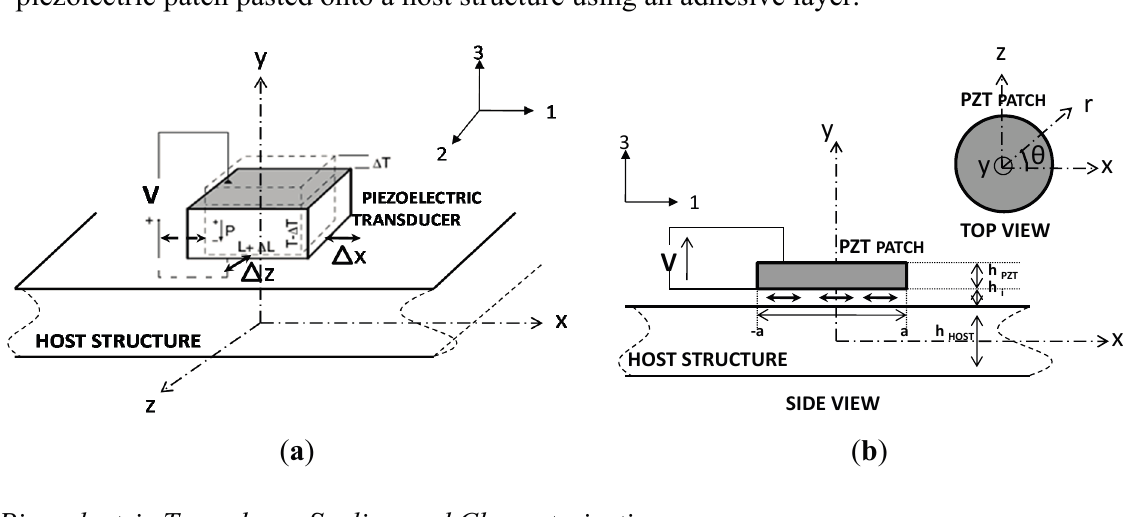
Figure 3. ( a ) Piezoelectric transducer mounted onto a host structure surface; ( b ) Circular piezolectric patch pasted onto a host structure using an adhesive